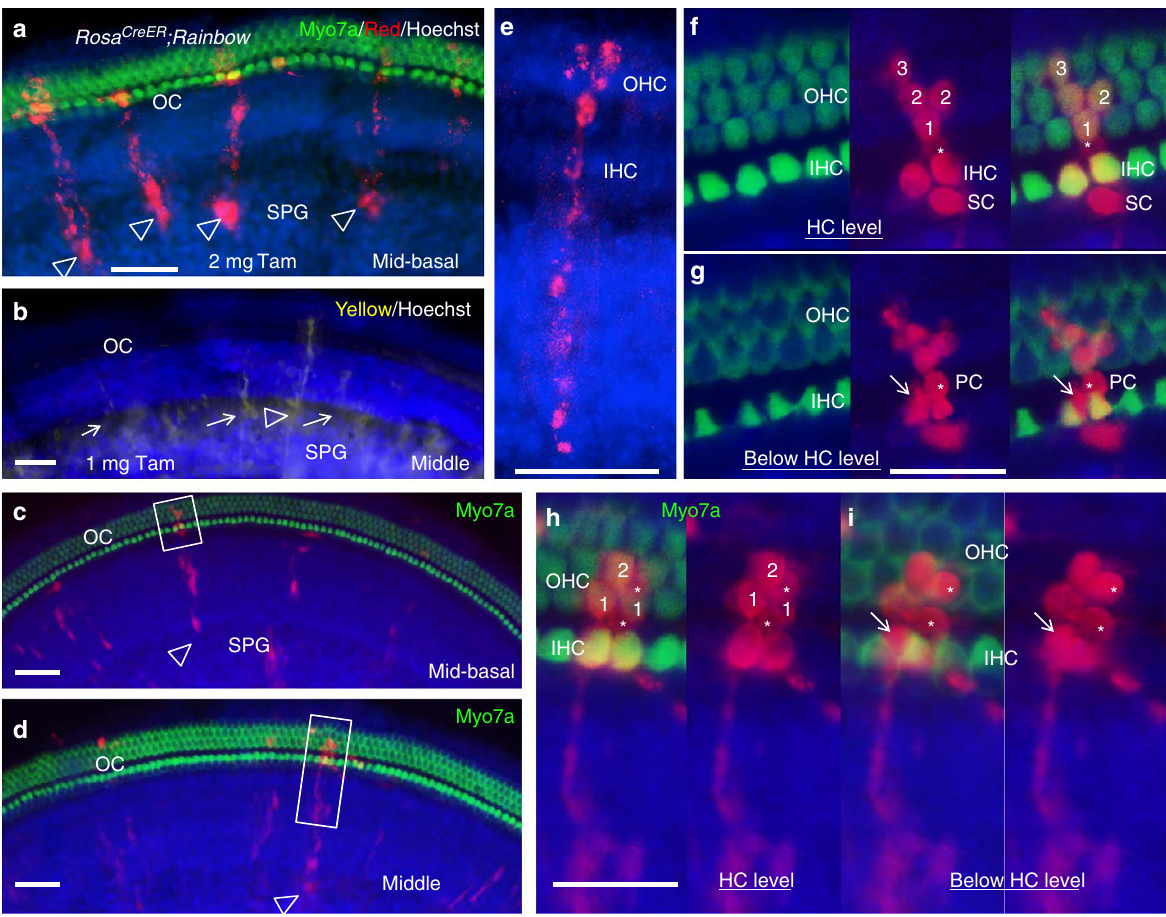
Figure 3 | Clonal tracing of individual cells in E18.5 cochlea. Rosa CreER ;Rainbow mice at E12.5 were injected with a single dose of tamoxifen (2mg). ( a , c , d ) Merged images of basal- or middle-turn cochlea stained with anti-Myo7a (green) and Hoechst (blue) showing multiple isolated red clones originating in the spiral ganglion (SPG) and extending to the organ of Corti (OC) (arrowheads). ( b ) Merged image of middle-turn cochlea stained with Hoechst (blue) showing a yellow clone spanning from the SPG to the OC (arrowhead) and yellow clones originating in the SPG without reaching the OC (arrows). ( e ) Higher magnification showing a red clone spanning from the SPG to the OC. IHC and OHC, inner and outer hair cells. ( f , g ) Higher magnification of boxed area in c . ( f ) Image focussed on HCs showing co-labelling of Myo7a and RFP in IHCs and OHCs. ( g ) Merged image focussed on the PC (pillar cell) between IHC and OHC (asterisk) in f . ( h , i ) Higher magnification of boxed area in d . ( h ) Merged image focussed on the HCs showing co- labelling of Myo7a and RFP in HCs. ( i ) Merged image focussed on the two SCs (asterisks) in h to better show these two cells. Arrows point to more SCs surrounding IHCs within these clonal clusters. Scale bars: 50 m m ( a – e ); 30 m m ( f – i